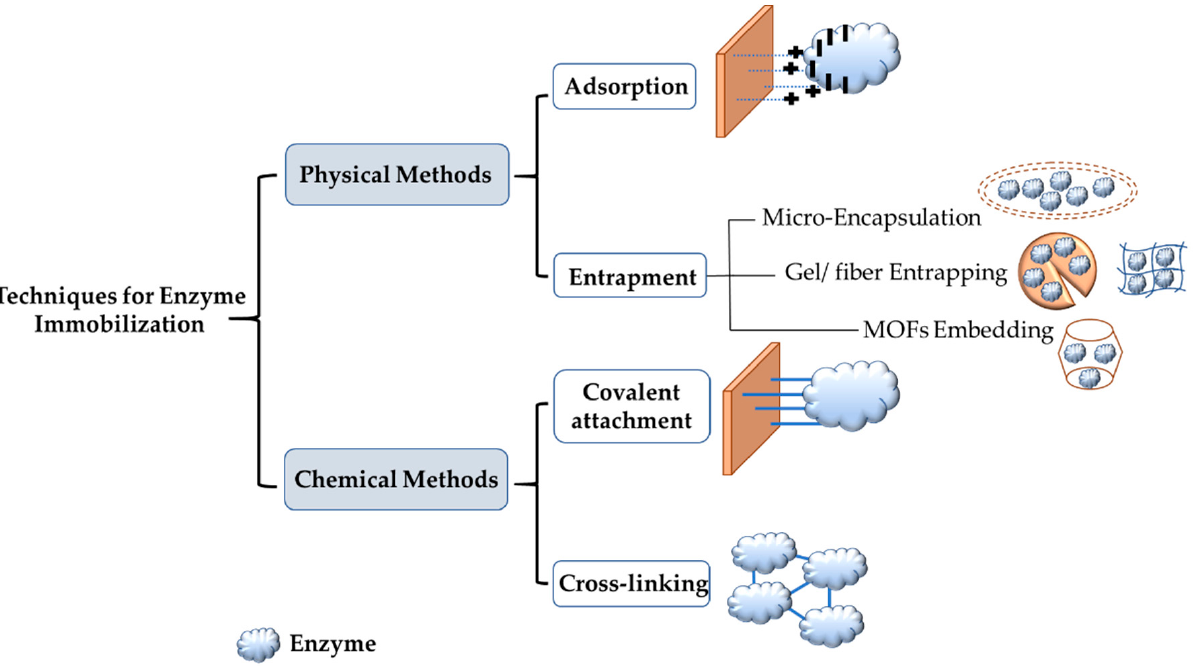
Figure 2. Commonly used approaches for enzyme